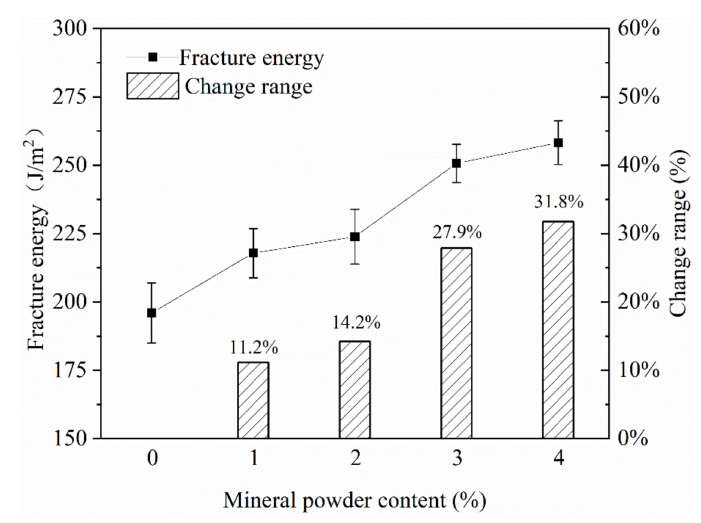
Figure 14. The e ff ect of mineral powder content on fracture energy.